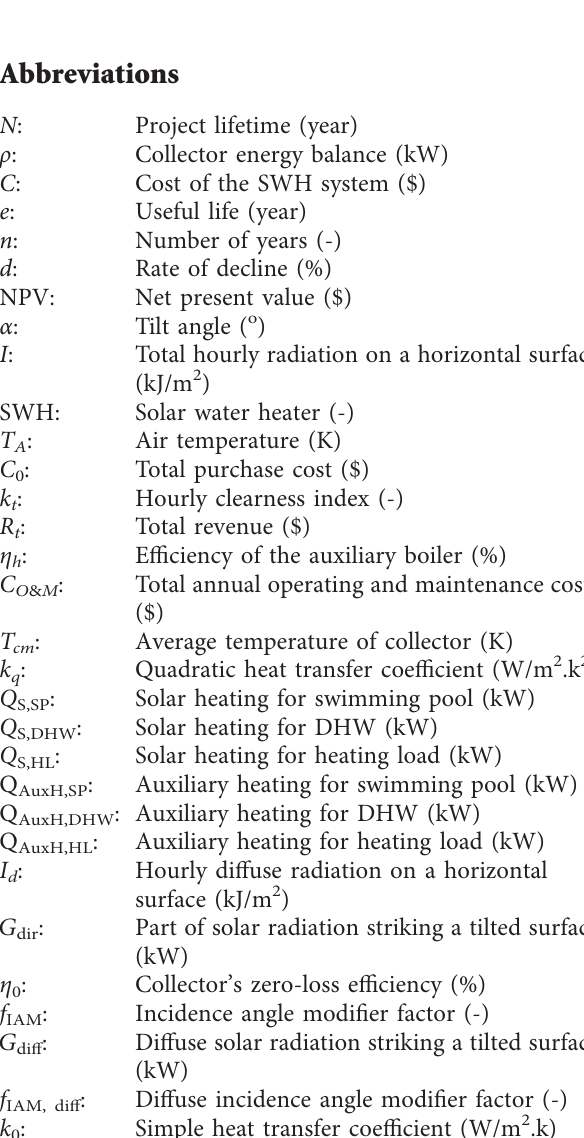
Figure 8: Economic analysis for the superior scenario over the lifetime of the